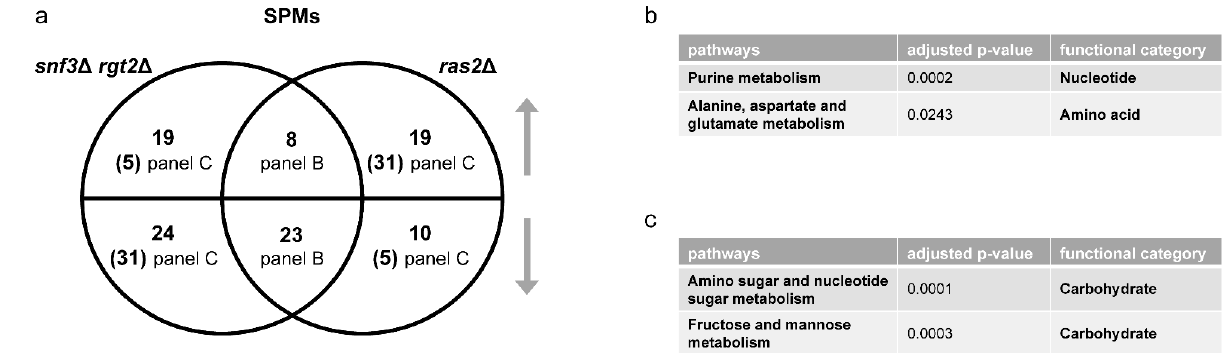
Figure 9. Comparing significantly perturbed metabolites (SPMs) of snf3 Δ rgt2 Δ and ras2 Δ . ( a ) Venn diagram of subsets of SPMs, for snf3 Δ rgt2 Δ vs. wildtype and ras2 Δ vs. wildtype, after glucose addition. The upper semicircle shows up-regulated SPMs and lower semicircle shows down-regulated SPMs. Numbers in parenthesis are shared SPMs regulated in the opposite direction, and are placed in the area corresponding to the direction of regulation. SPMs used for ORA analysis that are ( b ) shared and change in the same direction; ( c ) shared and change in the opposite direction. Listed are all pathways and their functional categories with adjusted p -value < 0.05.